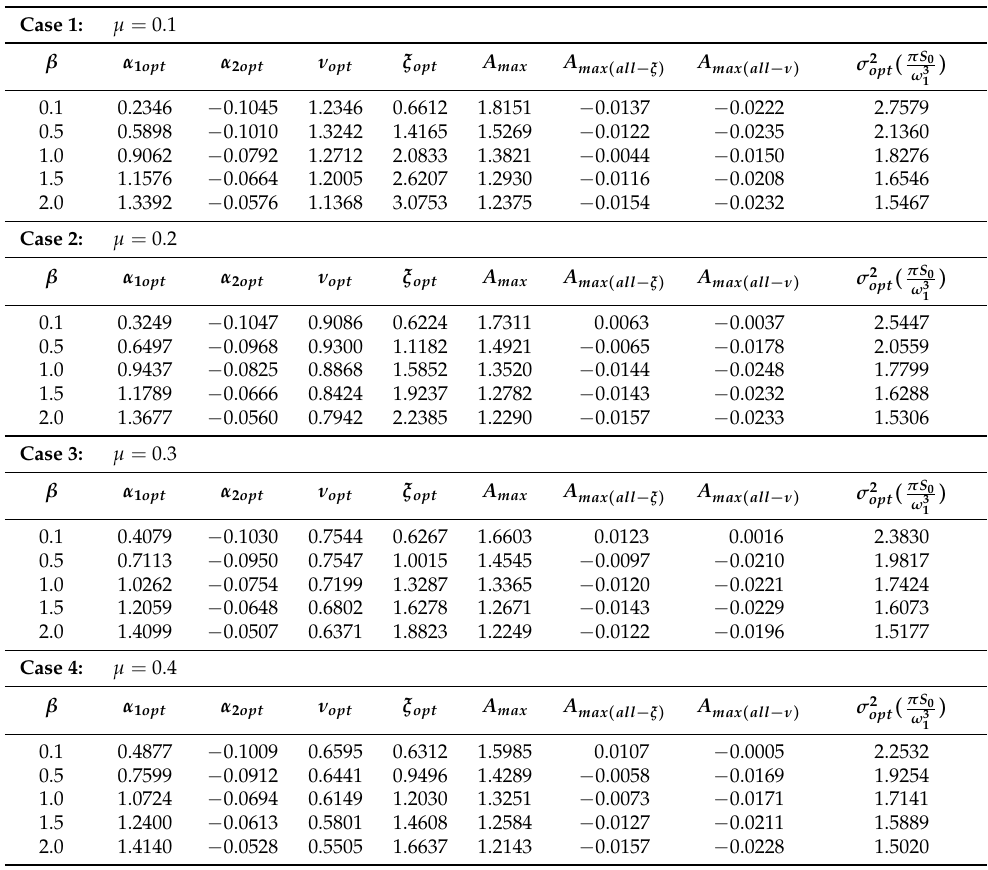
Table 4. The specific parameters of the system in different cases of inerter-to-mass ratio